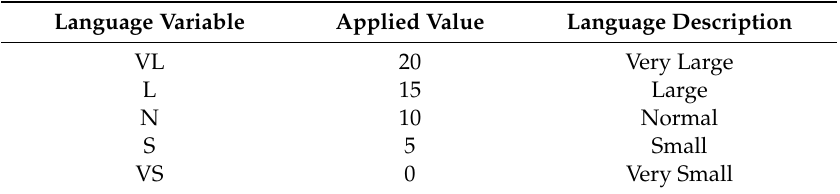
Table 4. Definition of the language variables for the SOC difference between battery cells .